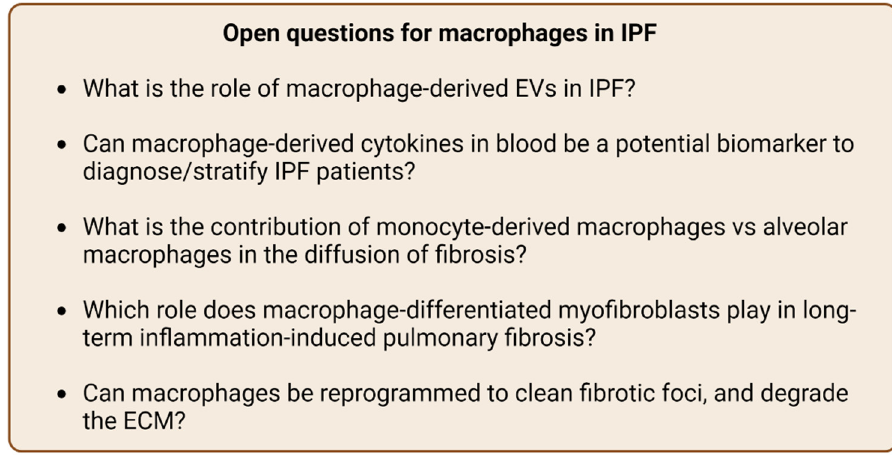
Figure 2. Open questions related to macrophage-related idiopathic pulmonary fibrosis.